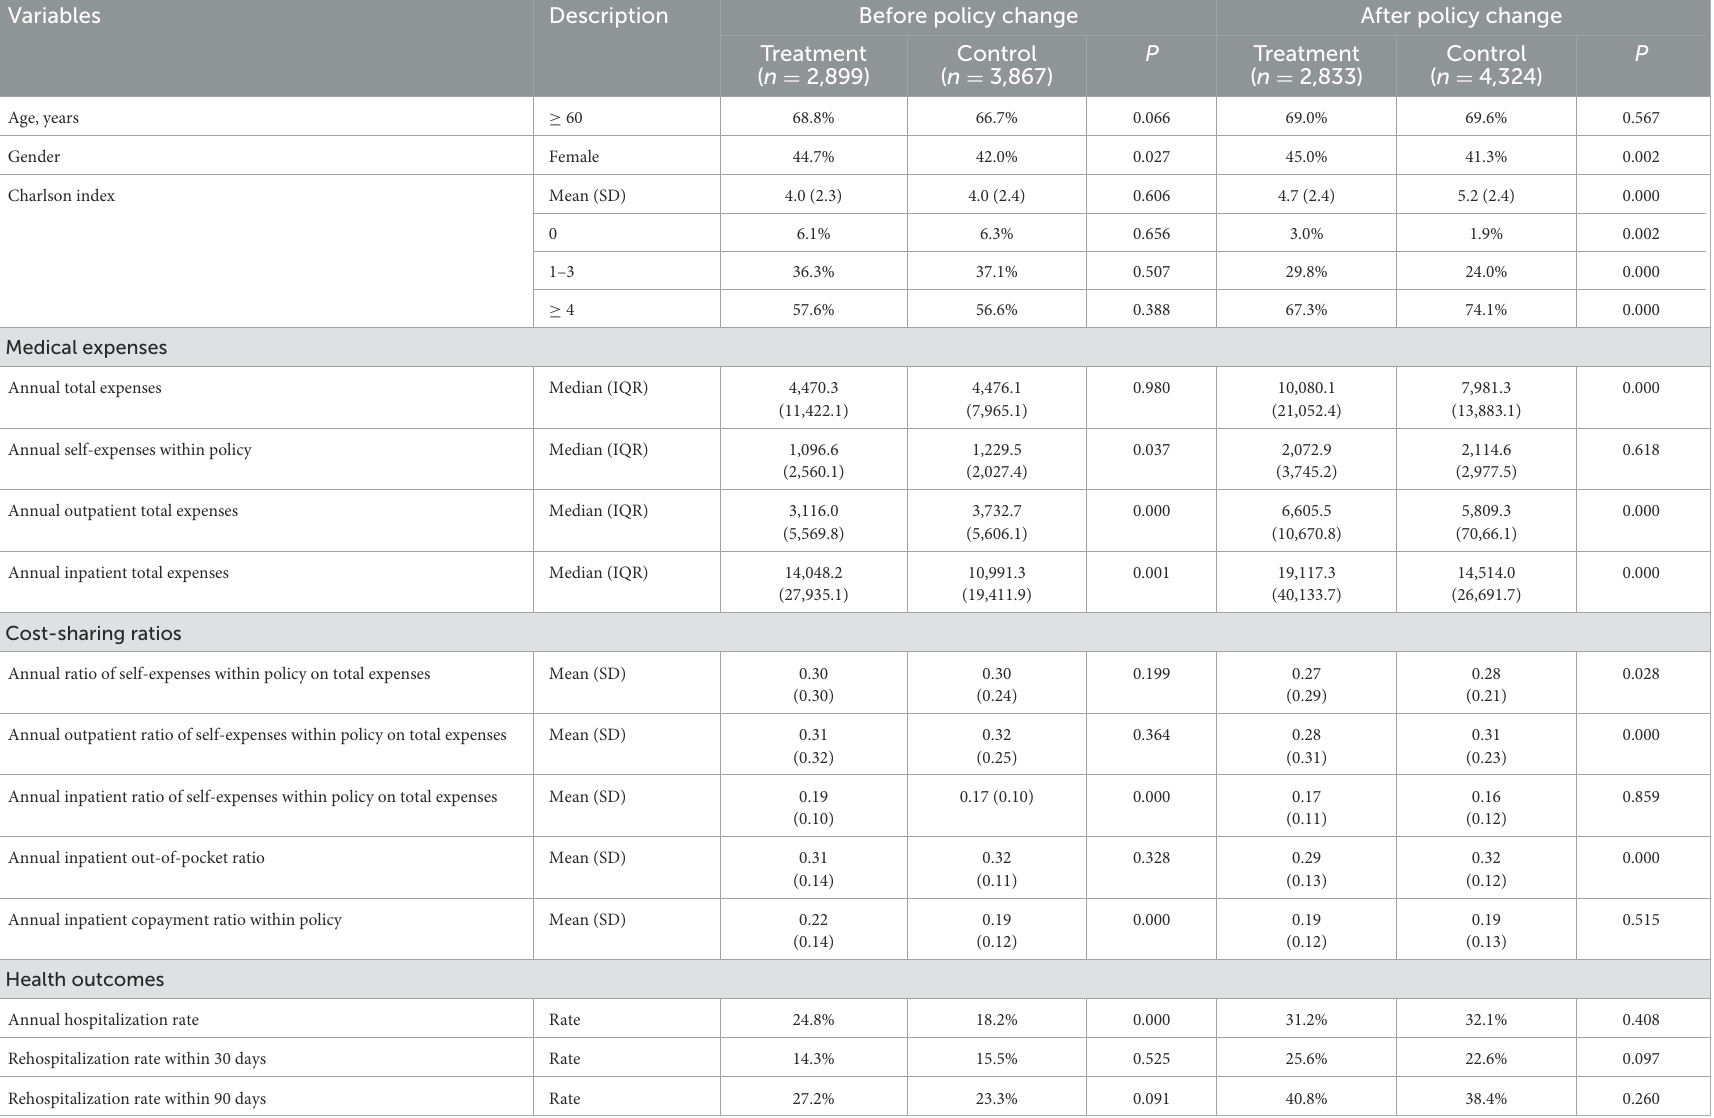
TABLE 4 Characteristics of study population before and after policy change.